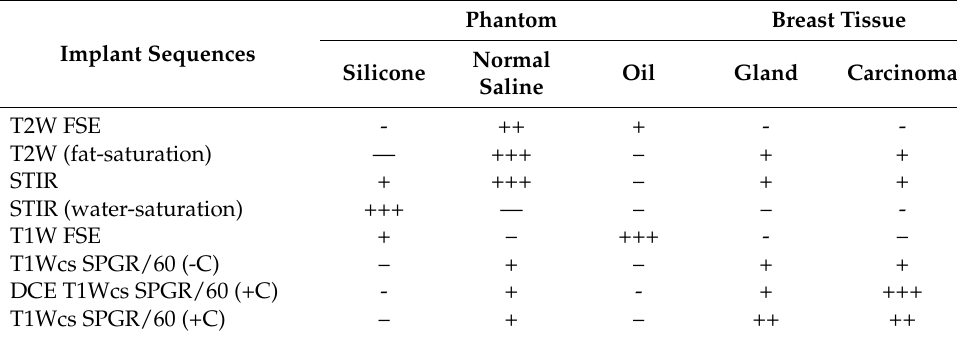
Table 2. Comparisons between the magnetic resonance images from three types of implants, normal mammary glands, and breast carcinomas.